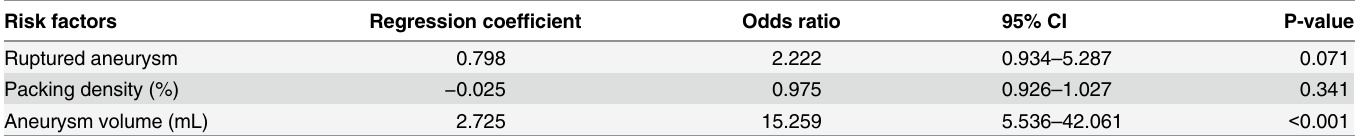
Table 2. Multivariate logistic regression analysis with five variables (packing density, aneurysm volume, neck, stent, and ruptured aneurysm). Risk factors